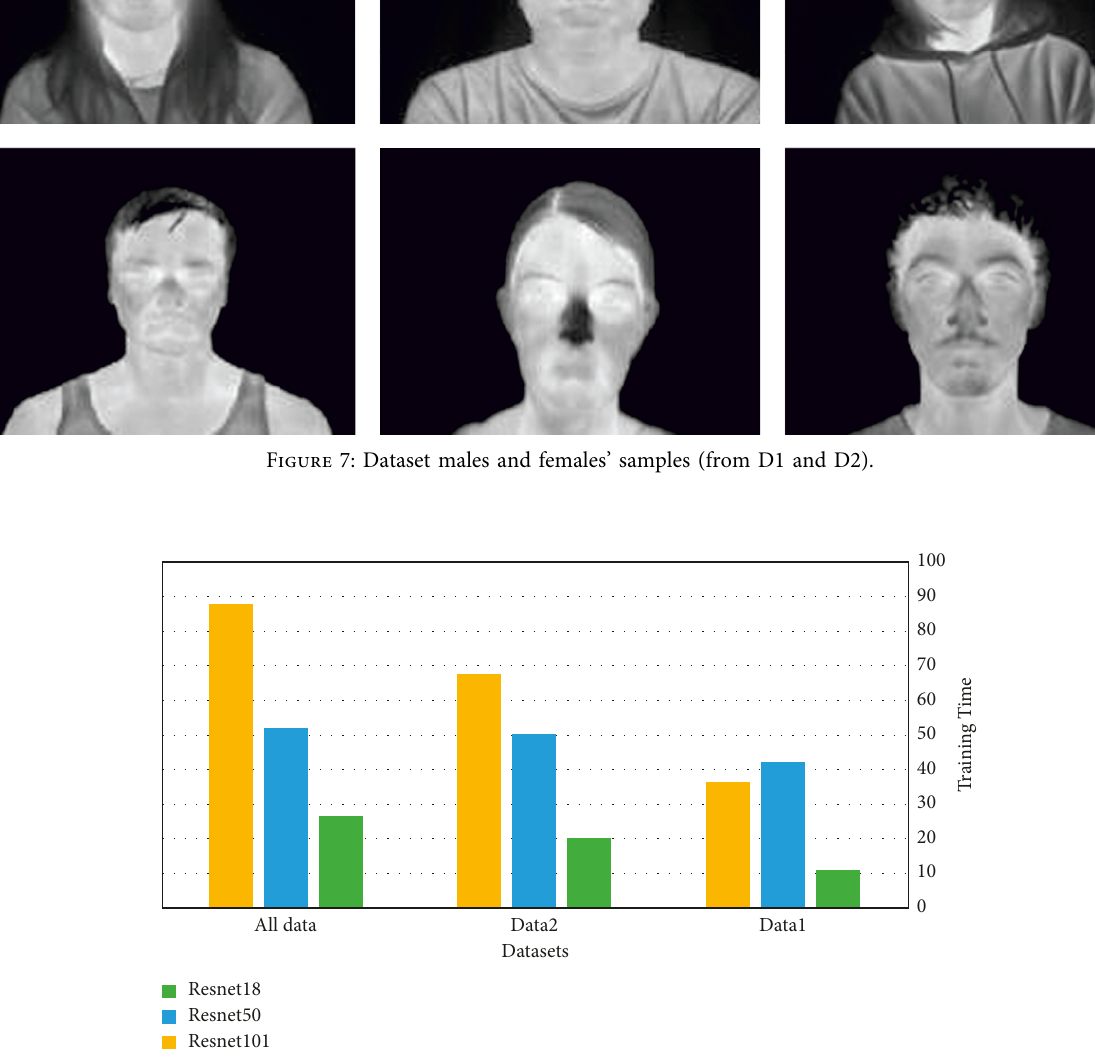
Figure 8: Training time comparison between the three